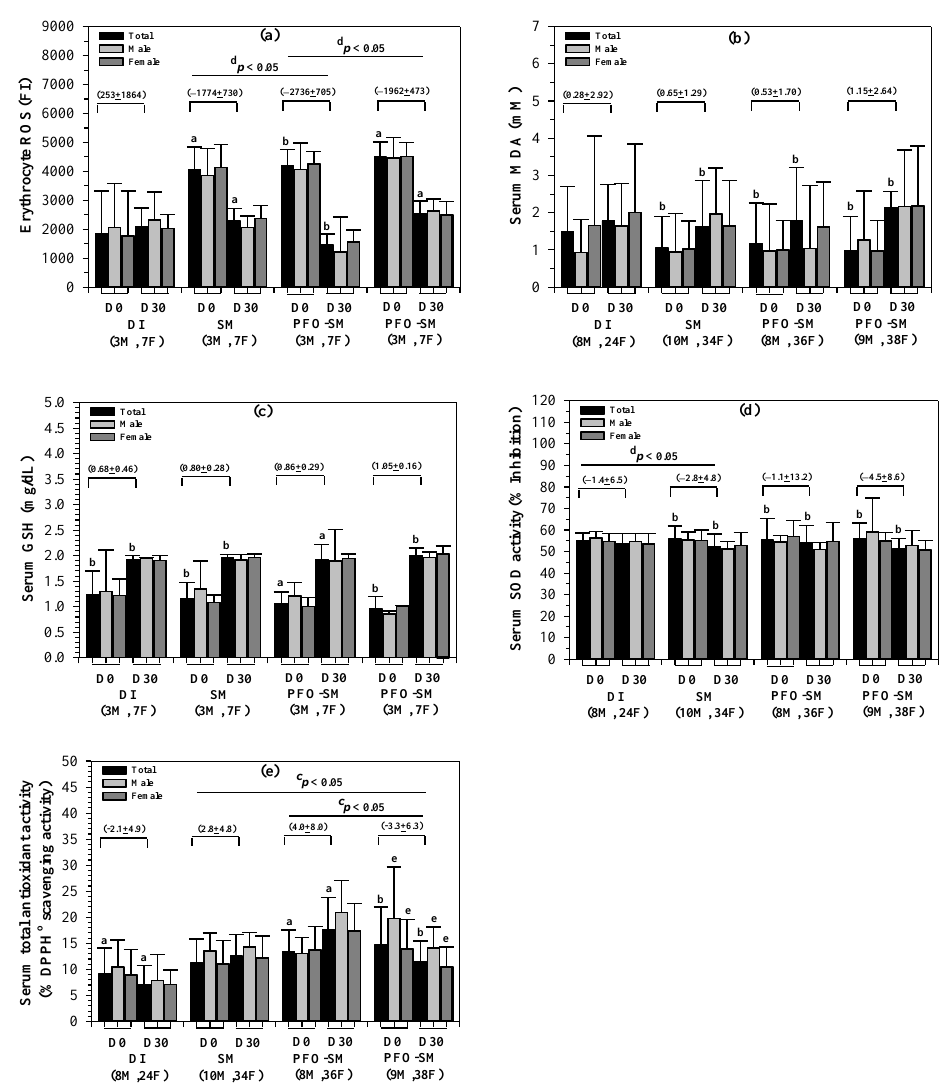
Figure 3. Levels of erythrocyte ROS ( a ), serum MDA ( b ), GSH ( c ), SOD activity ( d ), and TAC ( e ) in subjects who consumed the DI, SM, PFO-SM, and BS-SM drinks for 30 days are shown. Accordingly, a p values of <0.05 were considered significant when compared with the baseline data (D0) of the same group using a parametric paired Student’s t -test; b p values of <0.05 were considered significant when compared with baseline data (D0) of the same group using non-parametric Wilcoxon test; c p values of <0.05 were considered significant when comparisons were made between changes of all four groups (in brackets) using parametric one-way ANOVA followed by post hoc Tukey’s HSD or Dunnett T3 tests; and d p values of <0.05 were considered significant when comparisons were made between changes of the four groups (in brackets) using the non-parametric Kruskal-Wallis test; e p values of < 0.05 were con- sidered significant when comparisons were made between male and female subjects in the same group and at the same time using a parametric independent sample of the Student’s t -test. Abbreviations: DI = deionized water, DPPH = 2,2-diphenyl-1-picrylhydrazyl, F = female, FI = fluorescence intensity, GSH = reduced glutathione, M = male, MDA = malondialdehyde, PFO-SM = perilla fruit oil-soybean milk, ROS = reactive oxygen species, SD = standard deviation, SM = soybean milk, SOD = superoxide dismutase, TAC = total antioxidant